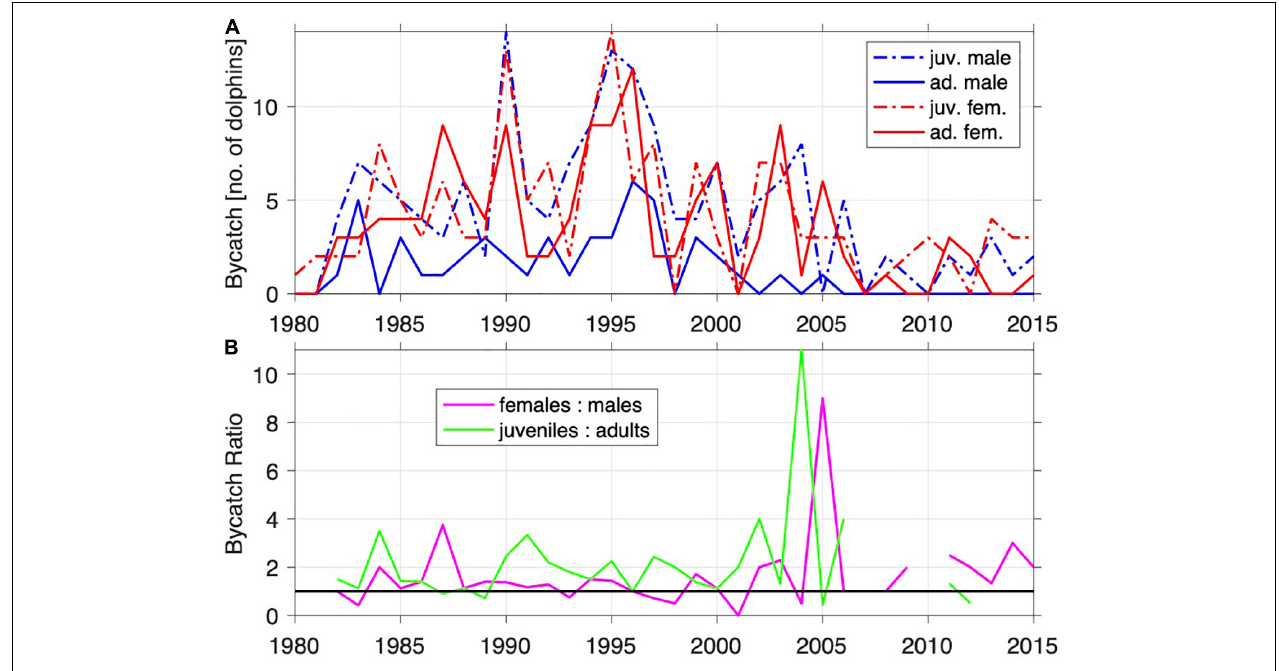
FIGURE 7 | Annual Indo-Pacific bottlenose dolphin ( T. aduncus ) bycatch from the SC by sex and sexual maturity (A) and ratios of sex and sexual maturity (B)